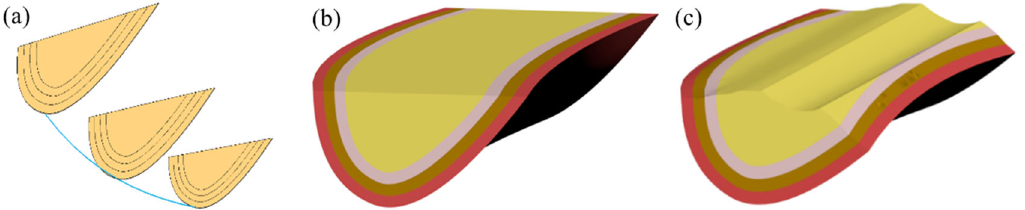
Figure 14. 3D symbol modeling process of the Danaobo mountain: ( a ) sections and hinge line of Danaobo mountain, ( b ) 3D symbol model of the Danaobo mountain upright syncline before trimming, and ( c ) 3D symbol model of the Danaobo mountain upright syncline after trimming.